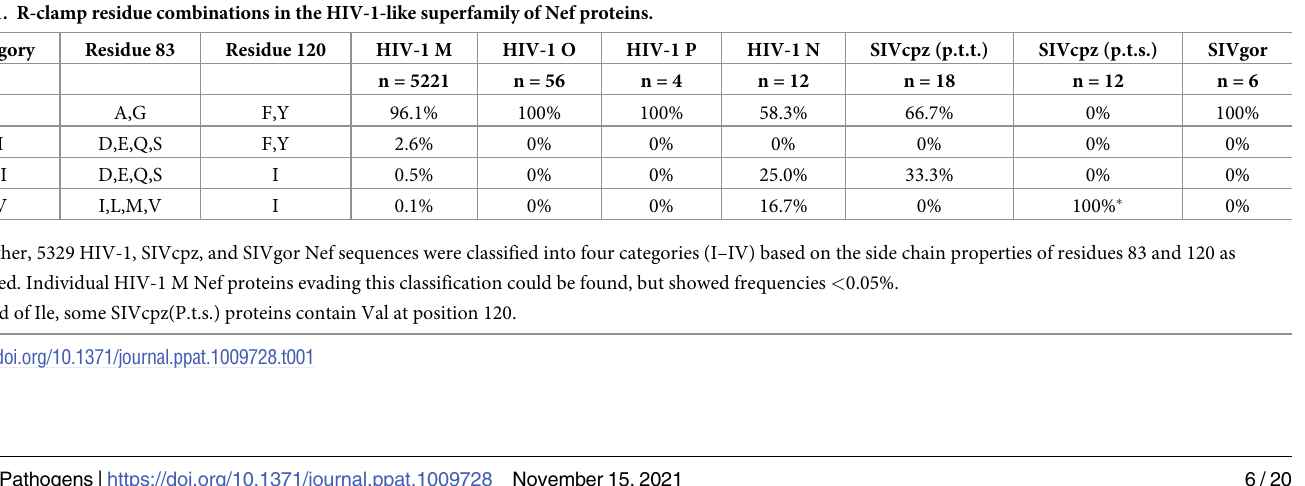
Table 1. R-clamp residue combinations in the HIV-1-like superfamily of Nef proteins. Category